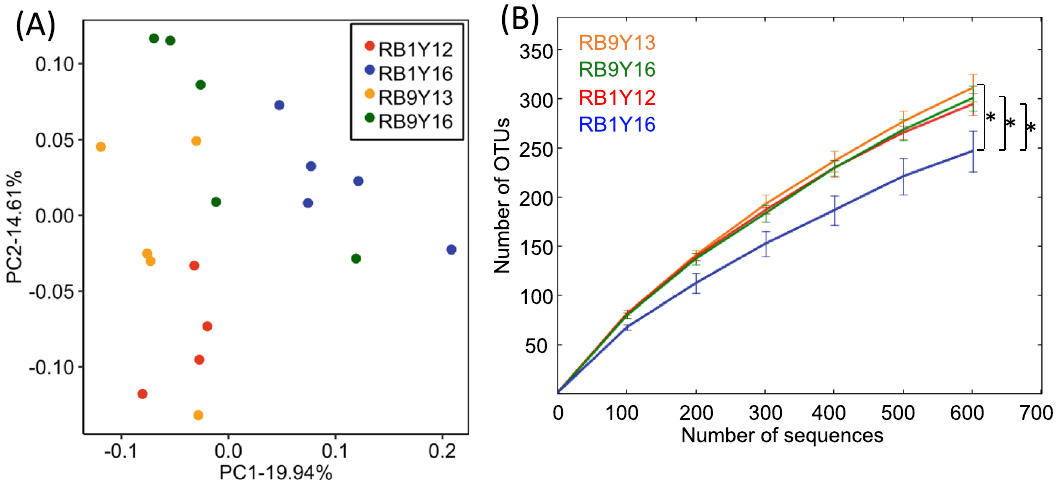
Figure 4. ( A ) PCoA analysis based on weighted UniFrac distance and ( B ) rarefaction curves of 16S rRNA OTUs among Yaku sika groups. * P ≤ 0.015.